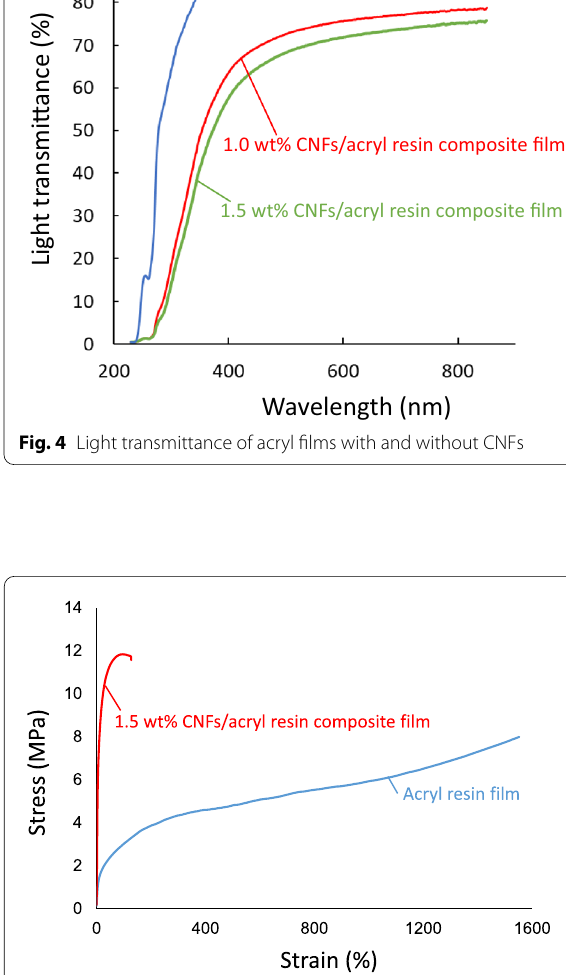
Table 1 Oxygen gas permeability of CNFs/acryl resin composite film